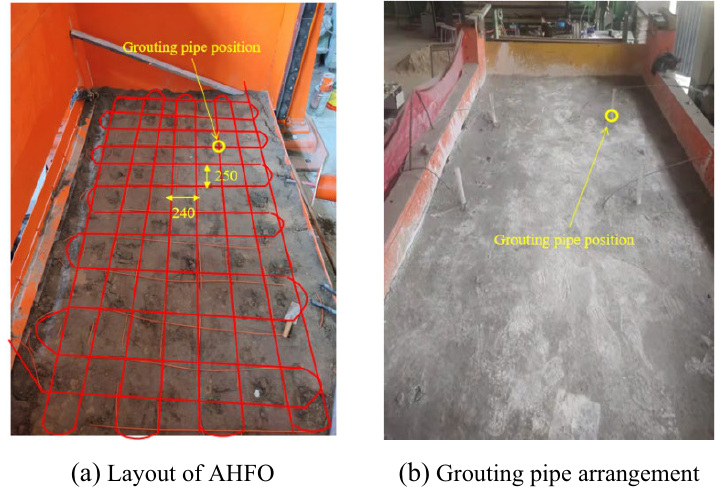
Figure 5. Large-scale 3D grouting model